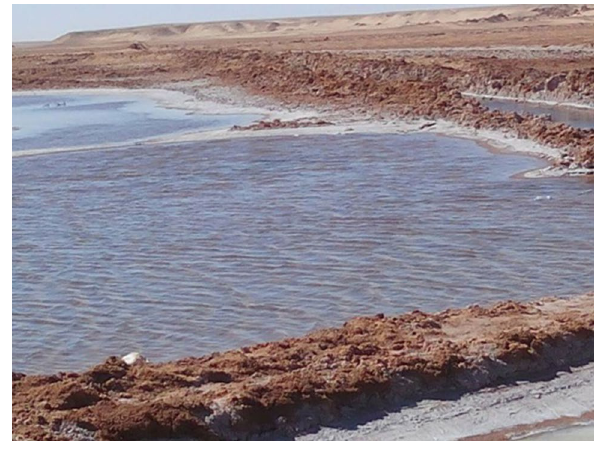
Fig. 22 Flooding of the Ben Draou Sebkha. (photo. Authors